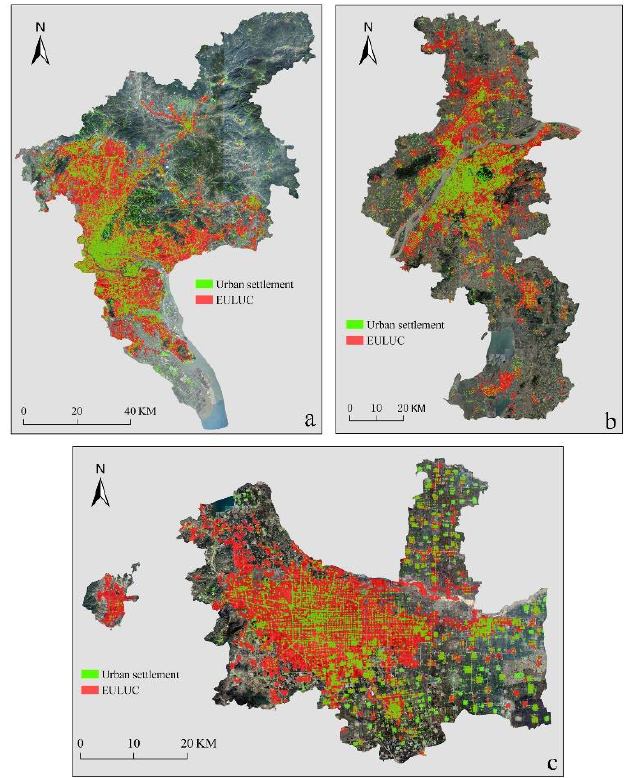
Figure 10. Comparison examples for urban territorial scope of Guangzhou ( a ), Nanjing ( b ) and Shijiazhuang ( c ).